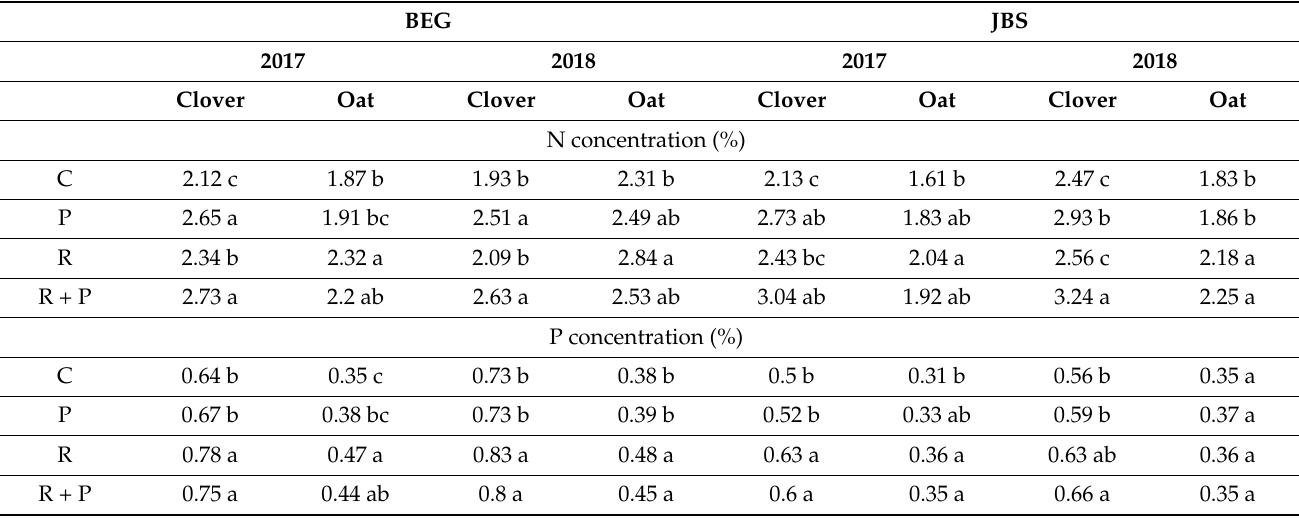
Table 3. Nitrogen (N) and phosphorus (P) concentrations (% in dry matter) in the intercropped clover and oats shoots (150 DAS) at the BEG and SBR sites for both experimental